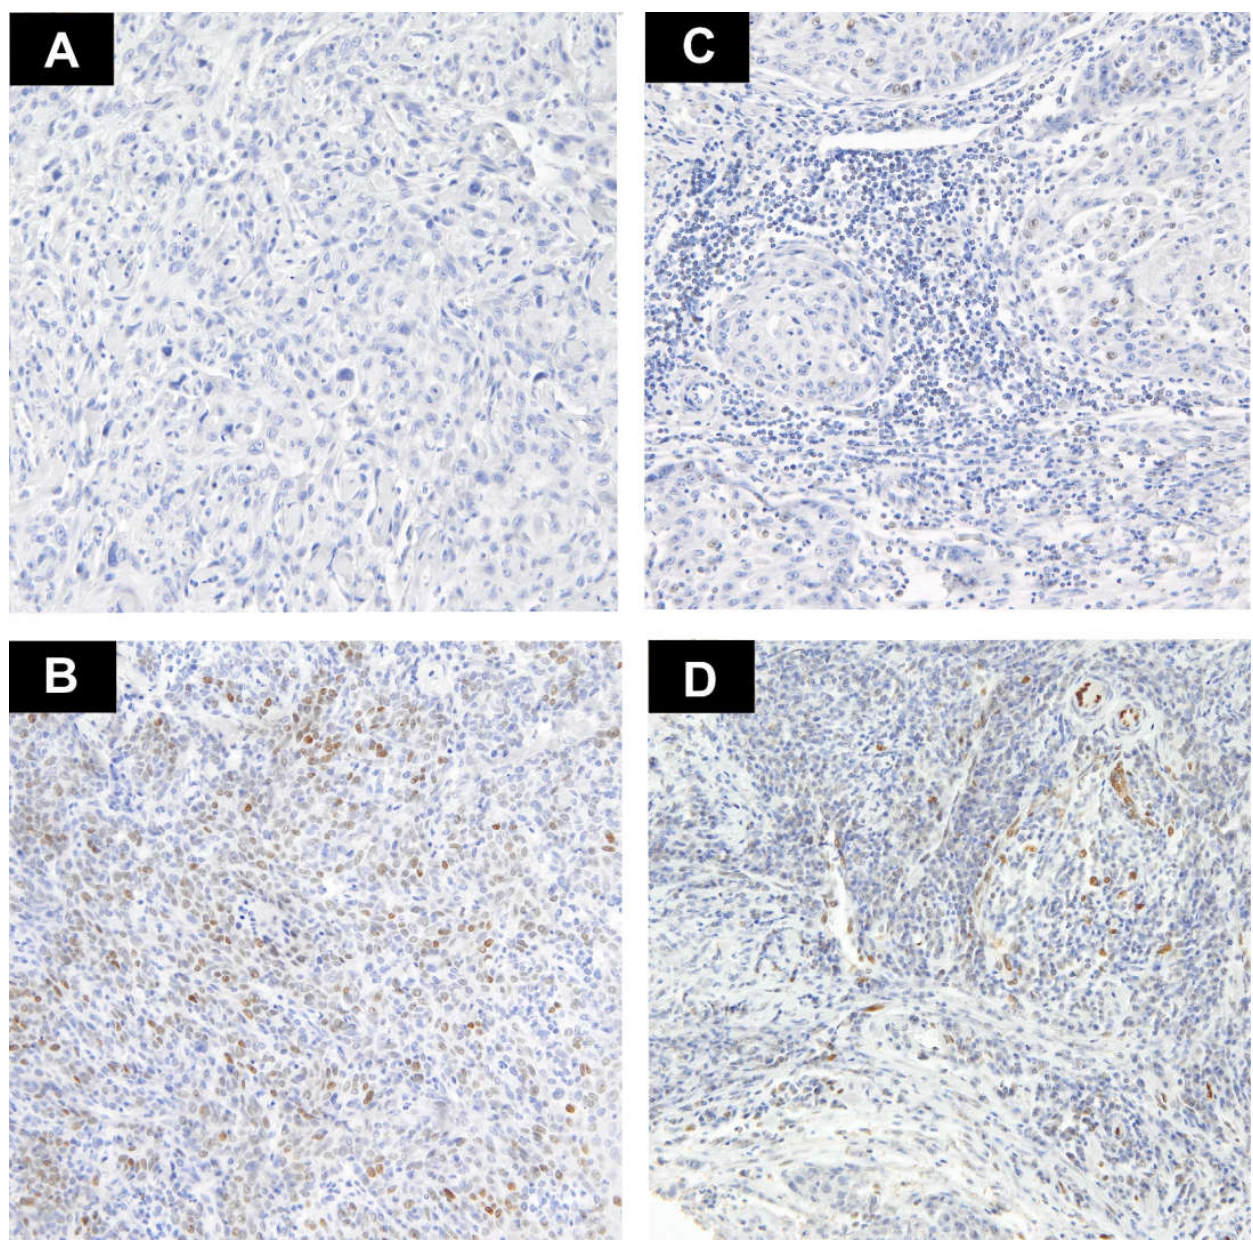
Figure 2. Representative examples of IL-33 staining (magnification ×10). ( A ) Tumor cells lacking IL-33 expression (no staining); ( B ) Positive nuclear staining with heterogeneous intensity in tumor cells; ( C ) TILs with negative IL-33 staining; ( D ) Weak positive nuclear staining in TILs and negative in TCs.